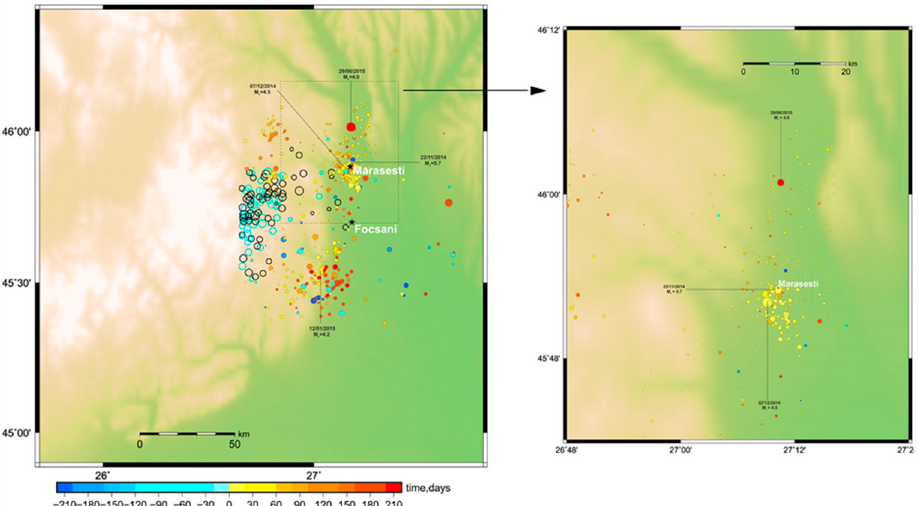
Figure 7. Epicenter distribution of selected earthquakes, colored according to the time of occurrence relative to the main earthquake (22 November 2014; 19:14 GMT). Cold colors depict earthquakes that occurred before the main event, whereas warm colors show the earthquakes produced after the main event. The epicenters of subcrustal earthquakes (H > 50 km) are also depicted; those that occurred prior to the main earthquake are indicated in cyan, while those that occurred after the main earthquake are marked in black. Black dotted lines mark the area close to the Marasesti city ( left ). A zoom in showing the epicenters distribution of crustal earthquakes close to the Marasesti city ( right ). The size of the symbols is proportional to the magnitude of the earthquake.